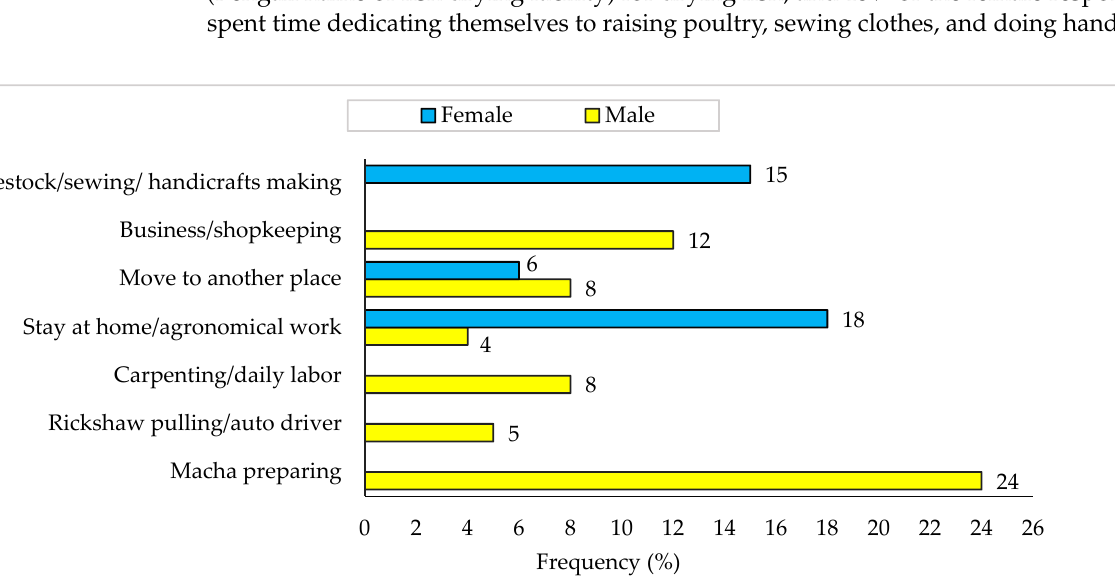
(Bengali name of fish drying facility) for drying fish, and 15% of the female respondents spent time dedicating themselves to raising poultry, sewing clothes, and doing handicrafts.